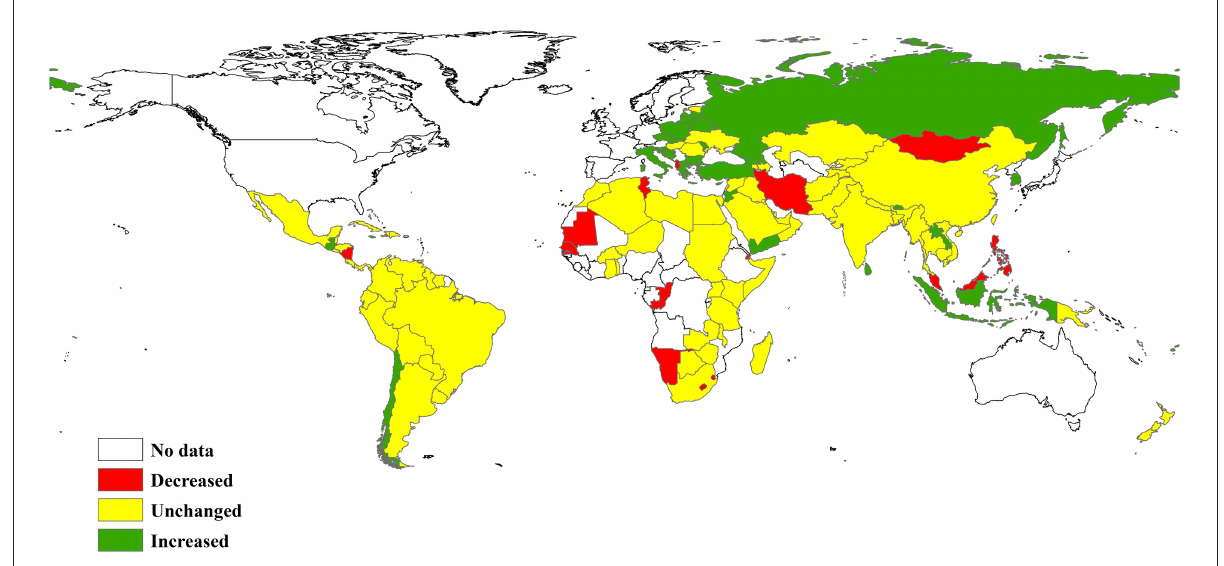
FIGURE1 Trend in the age of cigarette smoking initiation among adolescent smoking experiencers between 1999 and